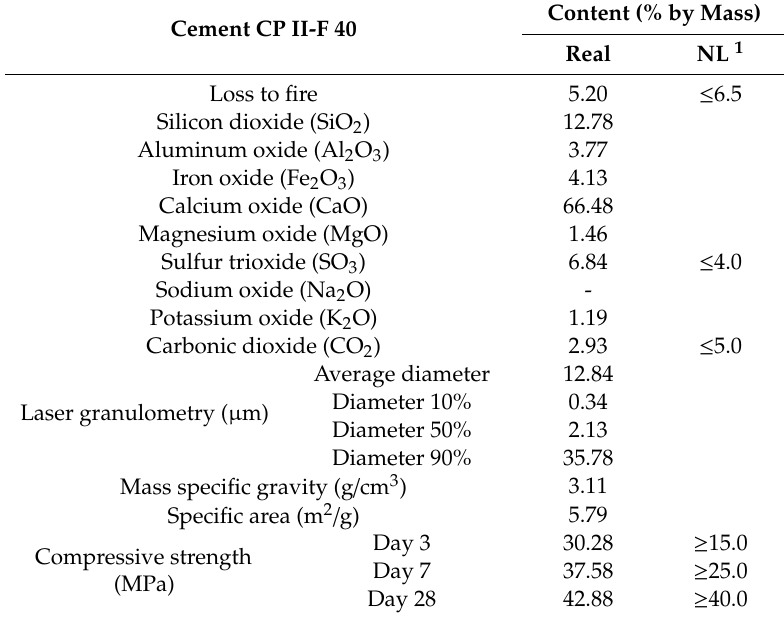
Table 1. Physicochemical characterization of CP II-F 40 cement.